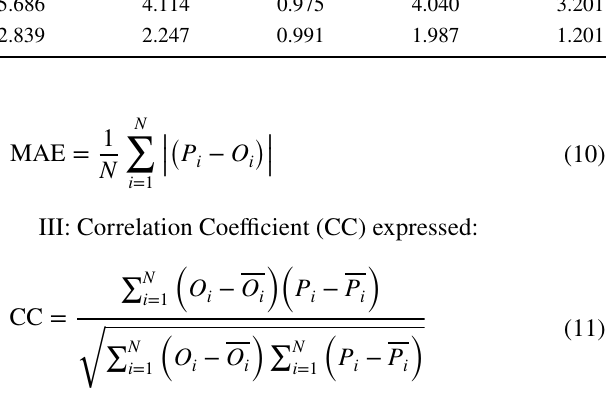
Table 4 The values of the performance criteria of the models for training and testing stages